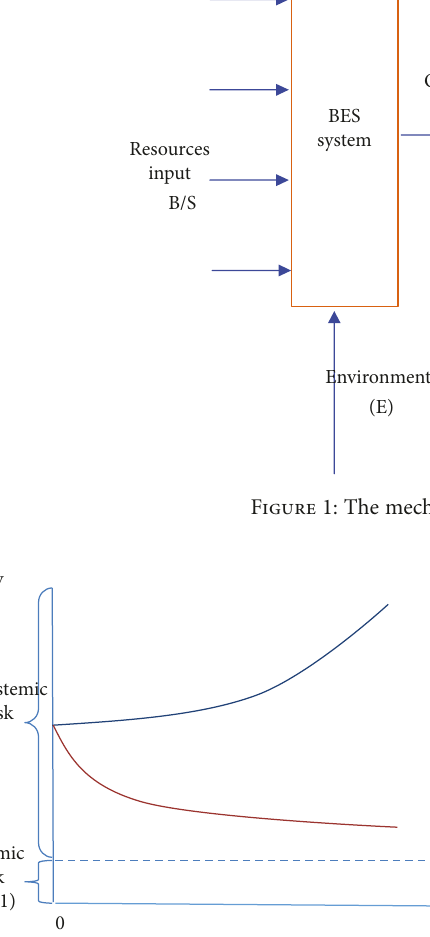
Figure 2: The relationship between credit assets and risk portfolio before and after